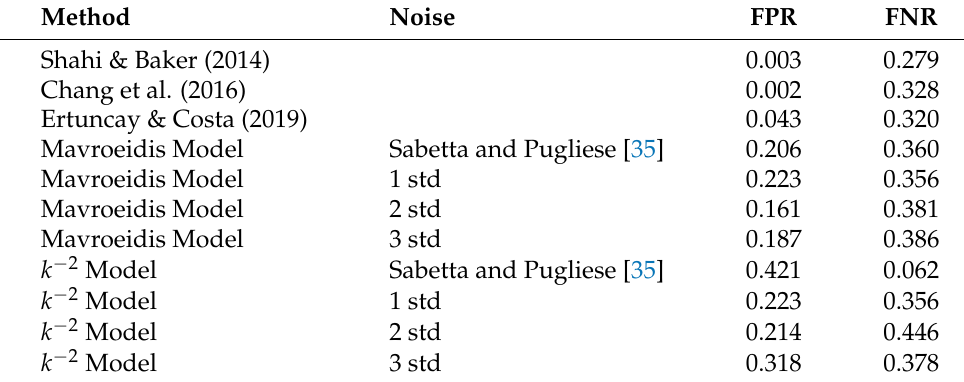
Table 3. FRP and FNR averaged over the